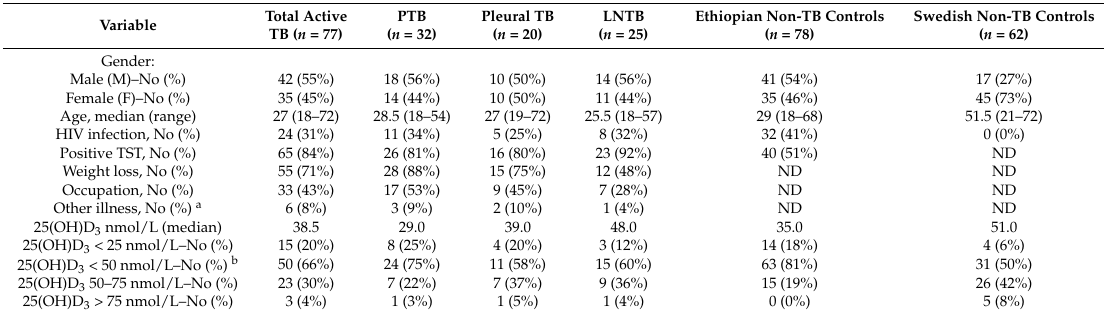
Table 1. Clinical demographics of the study participants.